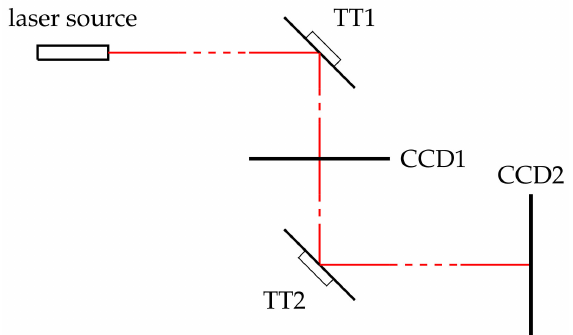
Figure 1. Simple scheme of the Electro-Optical Sampling station (EOS) laser alignment set up. TT1